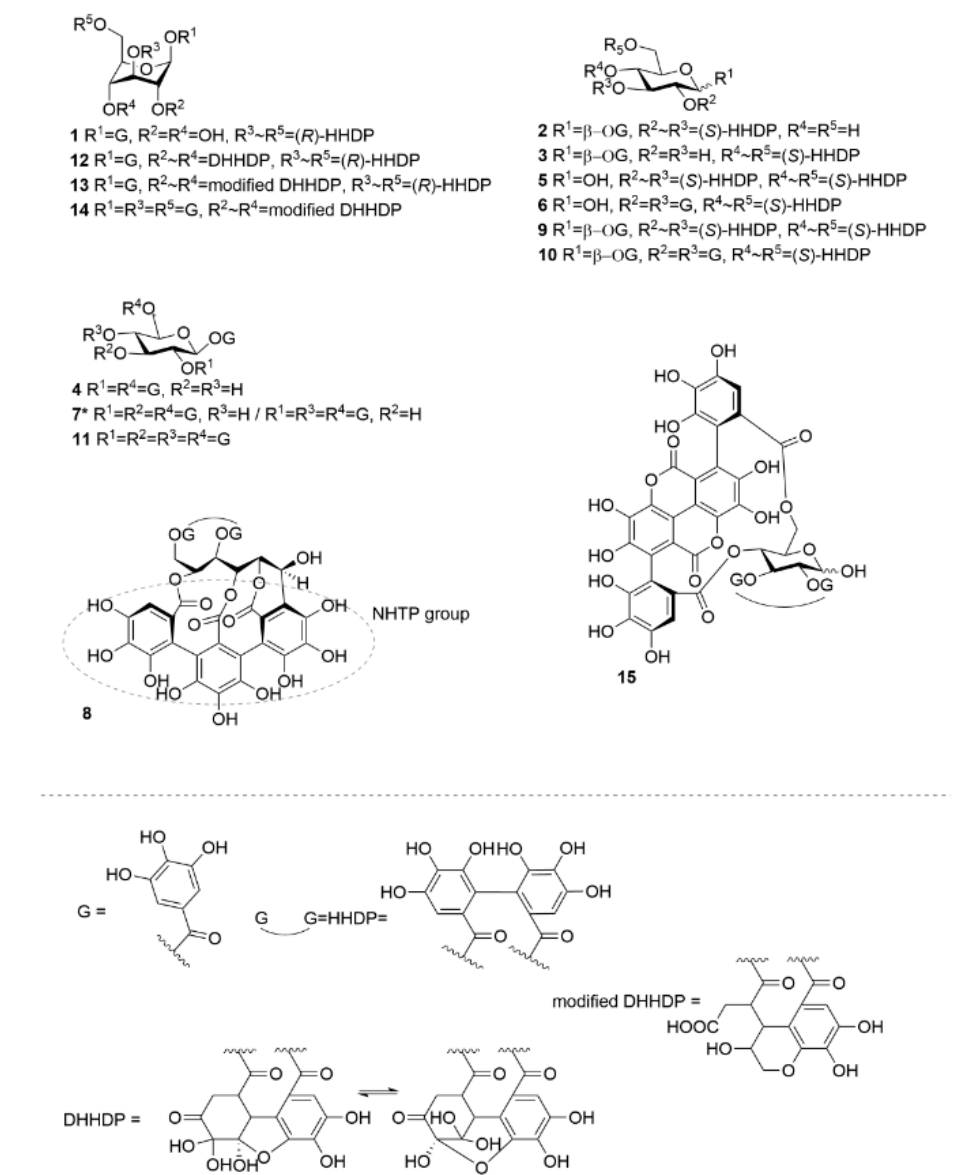
Figure 1. Chemical structures of monomeric hydrolysable tannins used in the study. DHHDP = dehydrohexahydroxydiphenoyl, G = galloyl, HHDP = hexahydroxydiphenoyl, NHTP = nonahydroxytriphenoyl. 1 , corilagin; 2 , isostrictinin; 3 , strictinin; 4 , 1,2,6-tri- O -galloyl- β - D -glucose; 5 , pedunculagin; 6 , tellimagrandin I; 7 , 1,2,3,6-tetra- O -galloyl- β - D -glucose/1,2,4,6-tetra- O -galloyl- β - D -glucose; 8 , vescalagin; 9 , casuarictin; 10 , tellimagrandin II, 11 , 1,2,3,4,6-penta- O -galloyl- β - D -glucose; 12 , geraniin, 13 , chebulagic acid; 14 , chebulinic acid; 15 , punicalagin. * Compound 7 was used as a mixture (0.42:1.00, n:n) of two structural isomers of tetragalloylglucose.